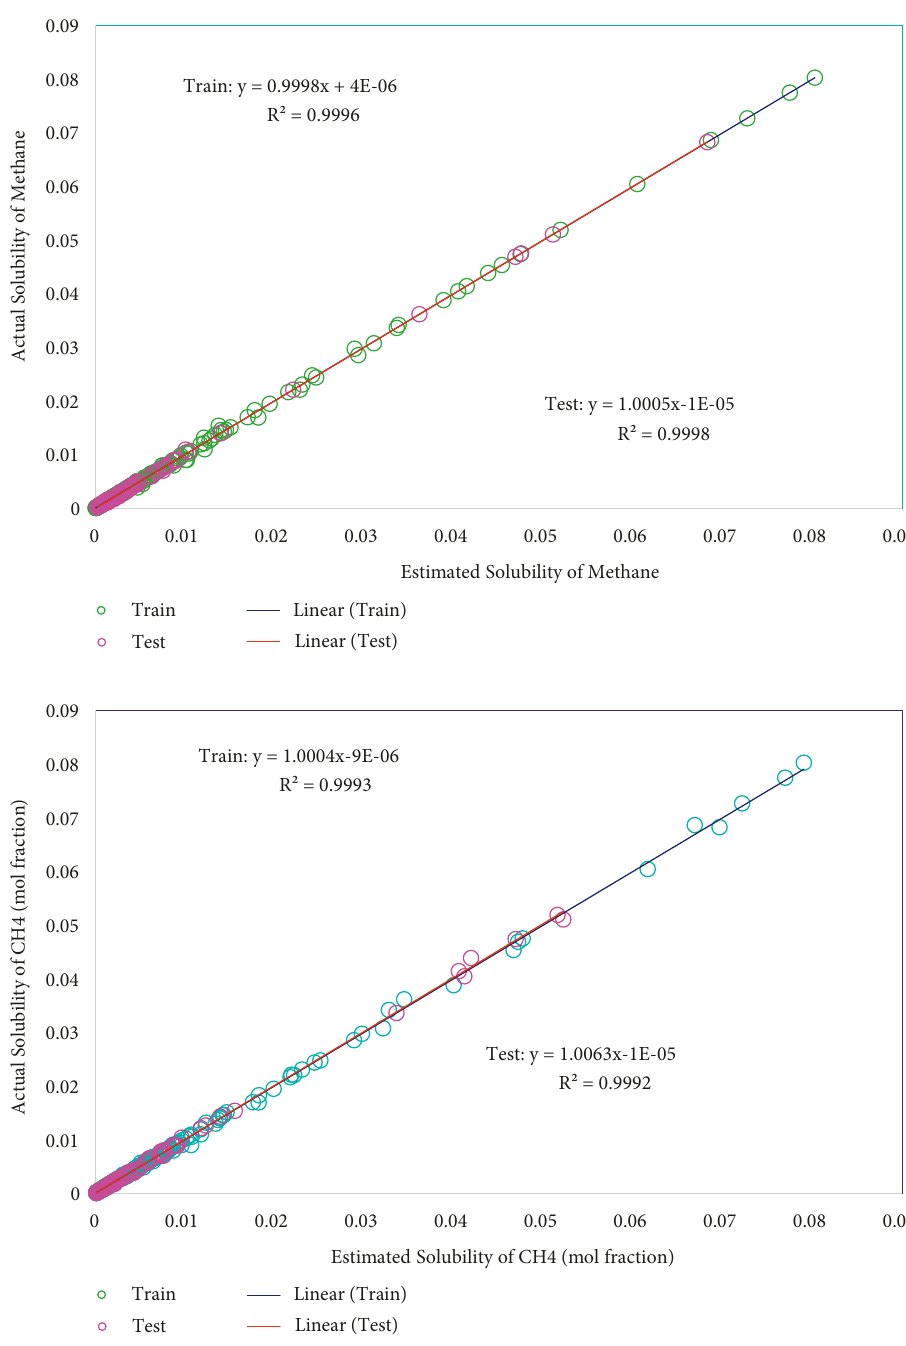
Figure 5: The cross plot of actual and estimated methane solubility values for (a) ANFIS (b)